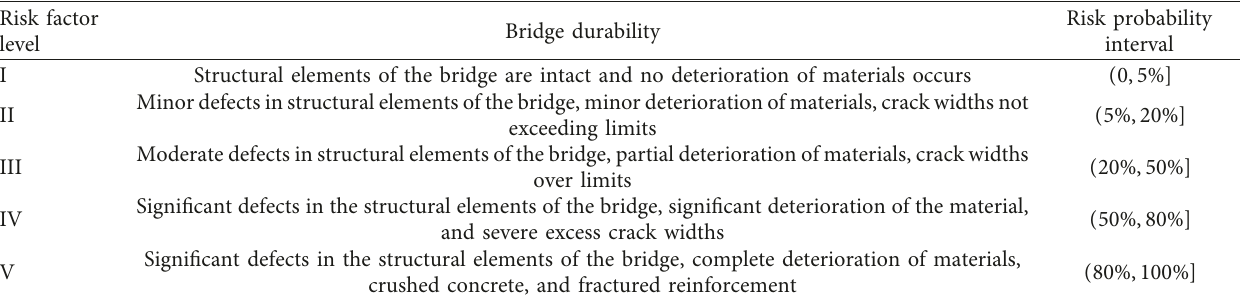
Table 4: Durability state classes of existing railway bridges.